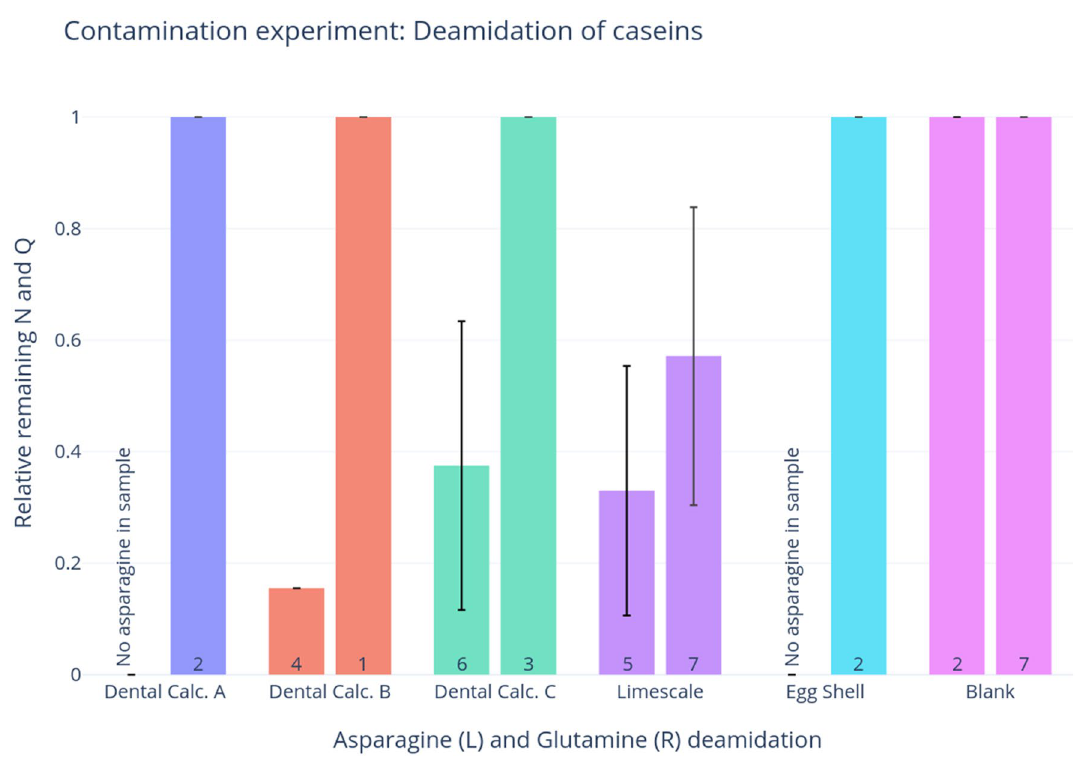
Figure 4. Bar graph of deamidation of asparagine (left) and glutamine (right) in contamination experiment samples. Error bars represent the standard deviation. The number of residues involved in this calculation is shown in each bar; plots produced through deamiDATE 24 .